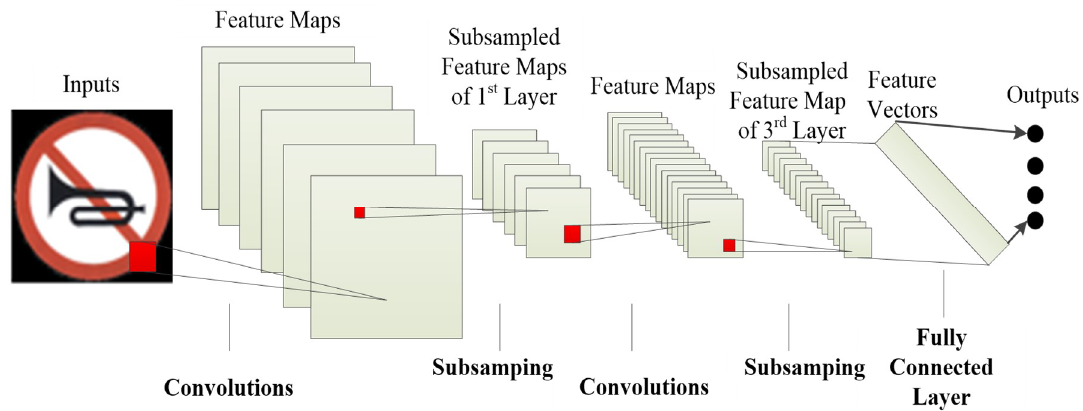
Figure 3. A standard architecture of a deep-learning Convolutional Neural Network (CNN).